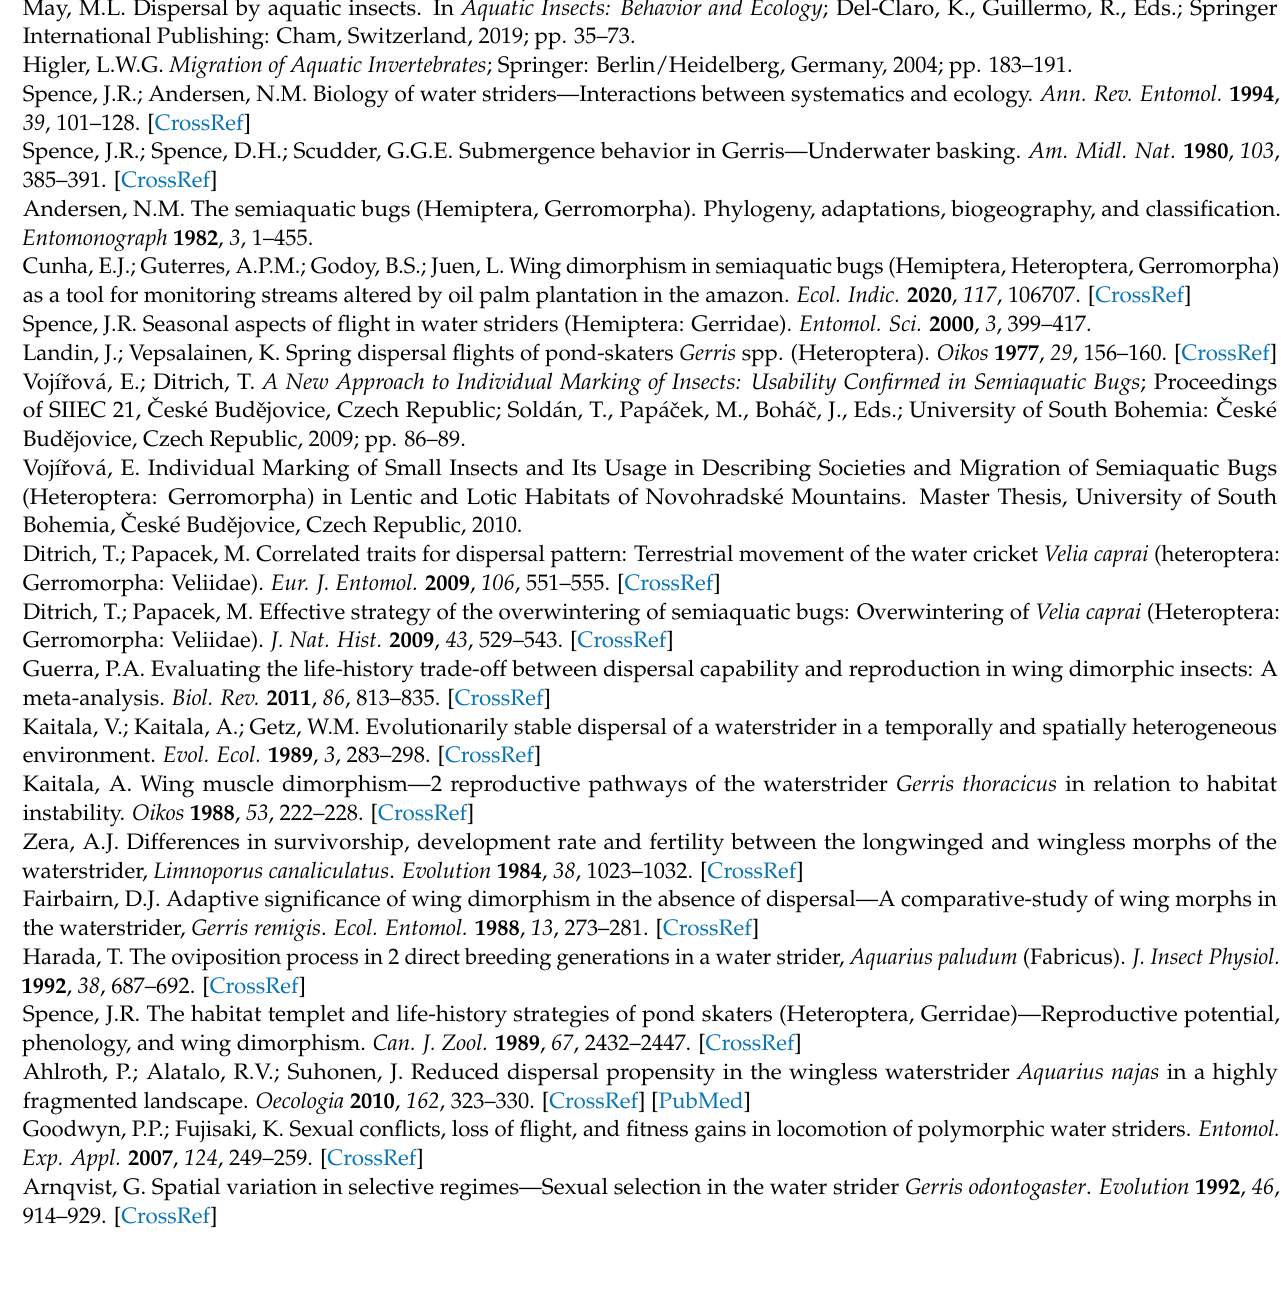
Figure S11: An aerial view of the Cep I small pool system; Figure S12: An aerial view of the Cep II small pool system; Figure S13: A picture of part of the stream where Velia caprai was